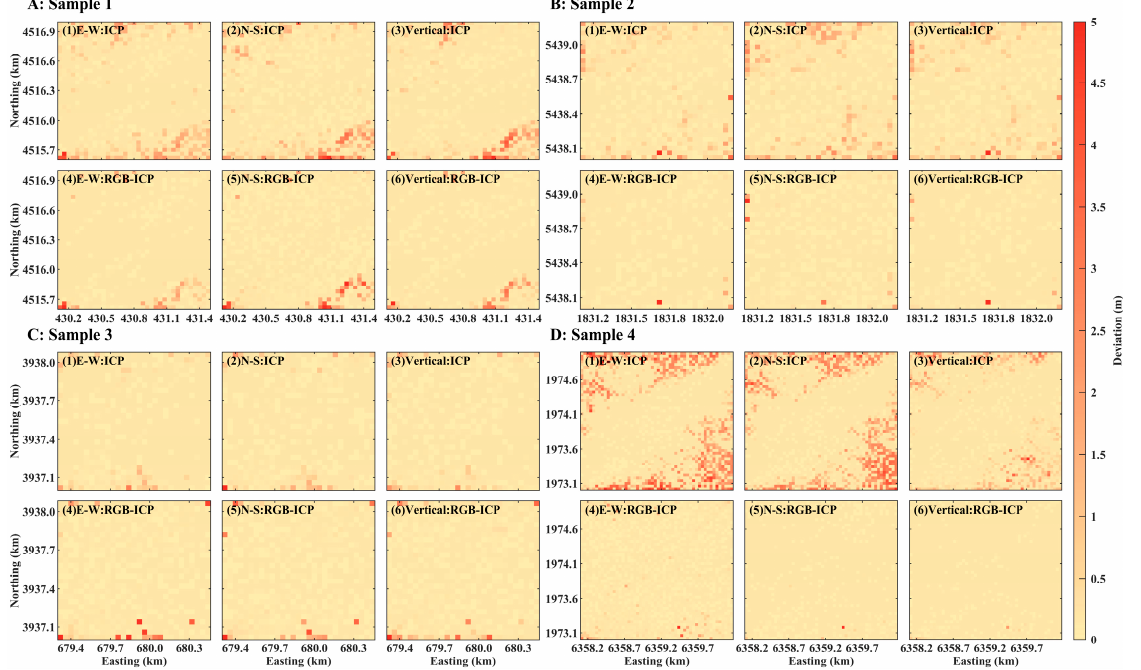
Figure 5. Distribution of absolute deviations of 3D deformation obtained by applying the two algo- rithms (rough terrain): ( A )–( D ) correspond to four groups of sample data, and each sample includes the deviation results of the ICP algorithm (( 1 )–( 3 )) and the RGB-ICP algorithm (( 4 )–( 6 )), where ( 1 ) and ( 4 ) are in the E-W direction; ( 2 ) and ( 5 ) are in the N-S direction; and ( 3 ) and ( 6 ) are in the vertical direction.